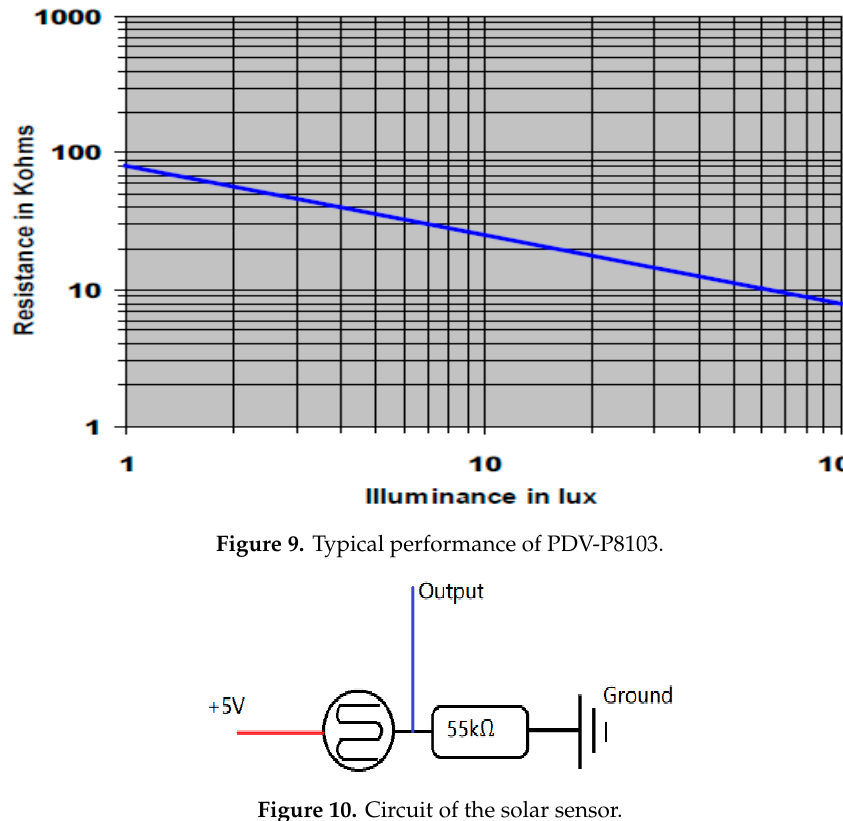
Figure 10. Circuit of the solar sensor.